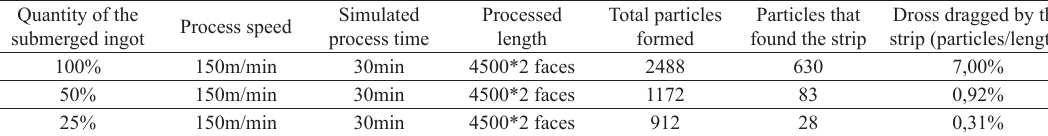
Table 3. Destination of top-dross particles during 30min of industrial process. Quantity of the submerged ingot